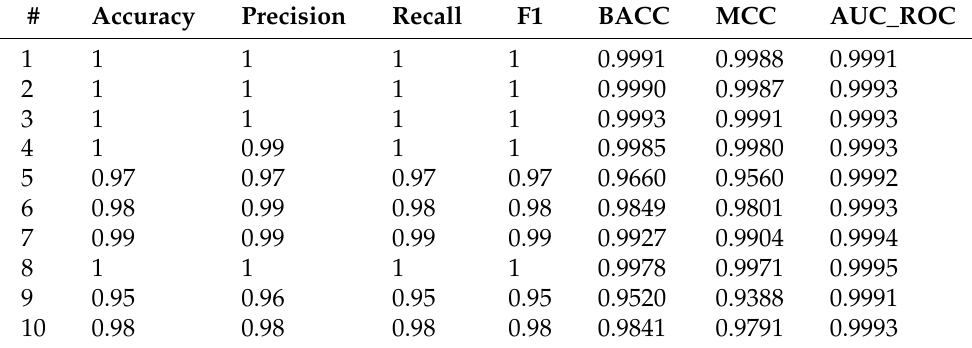
Table 9. Summary of the results for the Gradient Boosting Classifier.